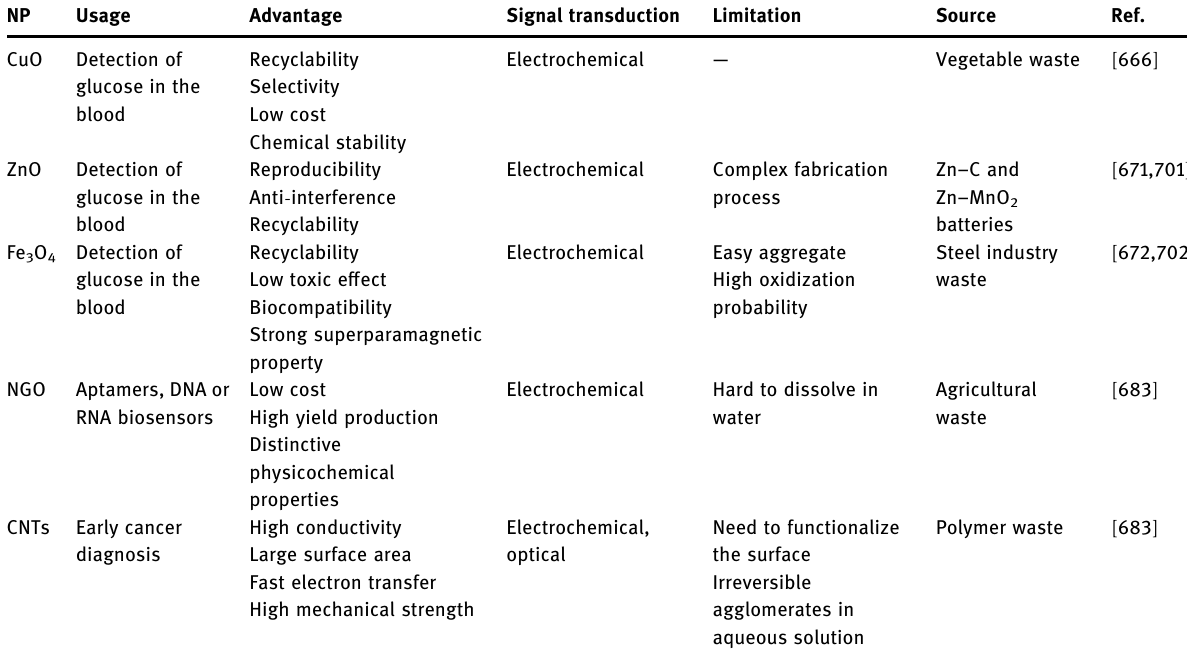
Table 13: NPs recycled from di ff erent sources of waste and utilized as biosensors for the early detection of di ff erent diseases